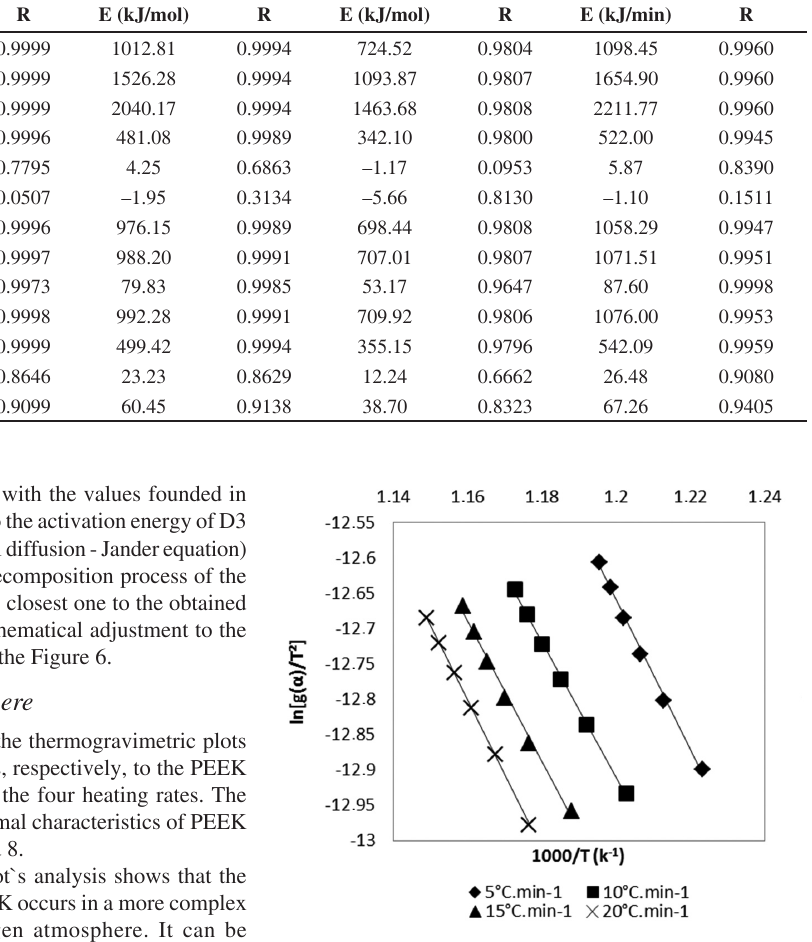
Figure 6. D3 equation adjusted to the Coats-Redfern method in the heating rates of 5 °C.min –1 ; 10 °C.min –1 ; 15 °C.min –1 and 20 °C.min –1